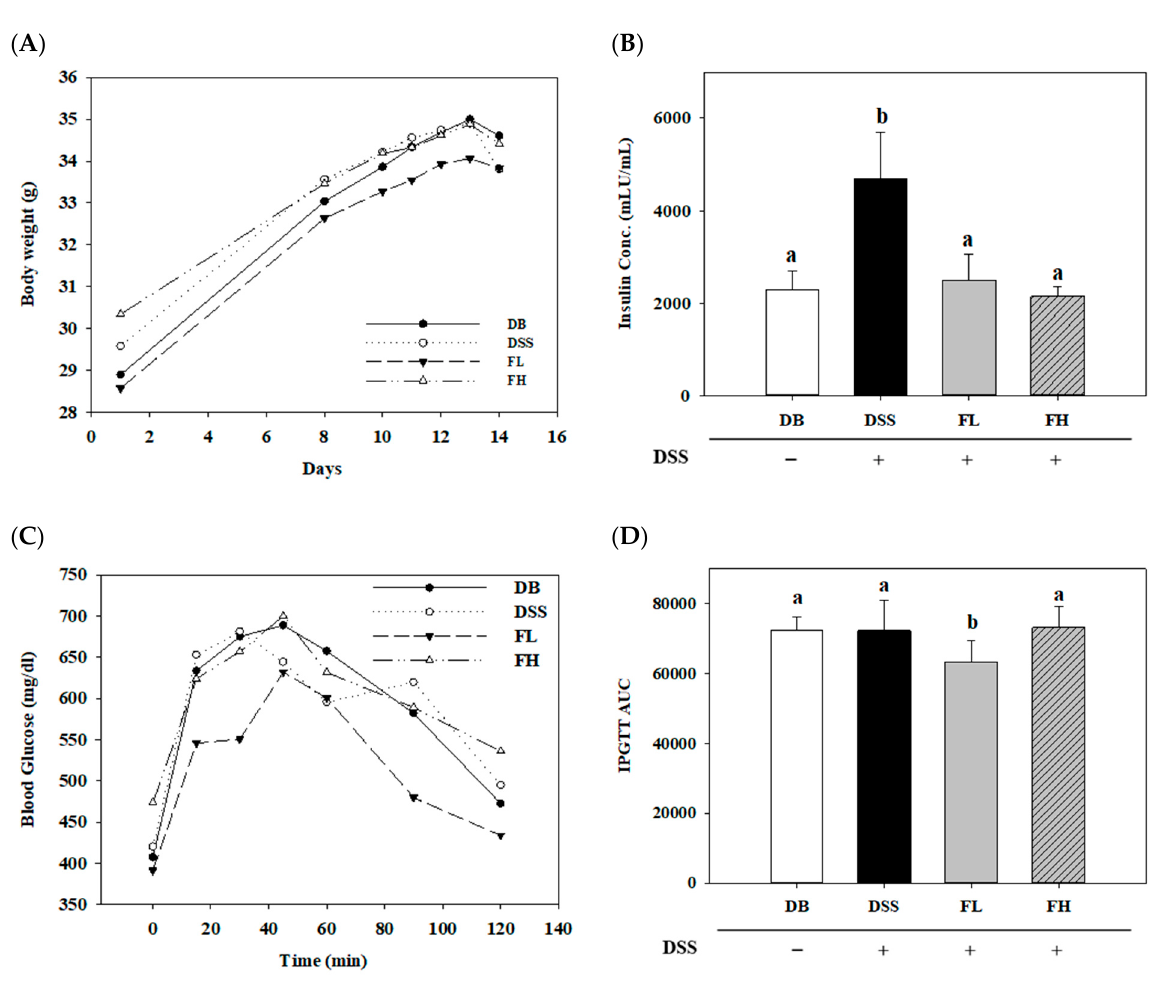
Figure 1. Effect of fermented Maillard reaction product (MRP) formed by Lactobacillus gasseri 4M13 ( L .4M13) (FMRP) on the changes in the body weight ( A ), serum insulin concentration ( B ), blood glucose level ( C ), and intraperitoneal glucose tolerance (IPGTT) area under the curve (AUC) ( D ) in the serum. The FL and FH groups were orally administered with low (FL; 750 mg/kg b.w.) and high (FH; 1500 mg/kg b.w.) FMRP concentrations, respectively. Mice were fed 2% dextran sulfate sodium (DSS) in water ad libitum for 5 d prior to euthanization in the DSS, FL, and FH groups for induced colitis. DSS +/- indicates whether 2% DSS is treated or not. Different letters (a–c) denote a significant difference ( p < 0.05) calculated via one-way ANOVA with Tukey’s multiple comparison test. Data are expressed as means ± SD. Six mice were included per group.